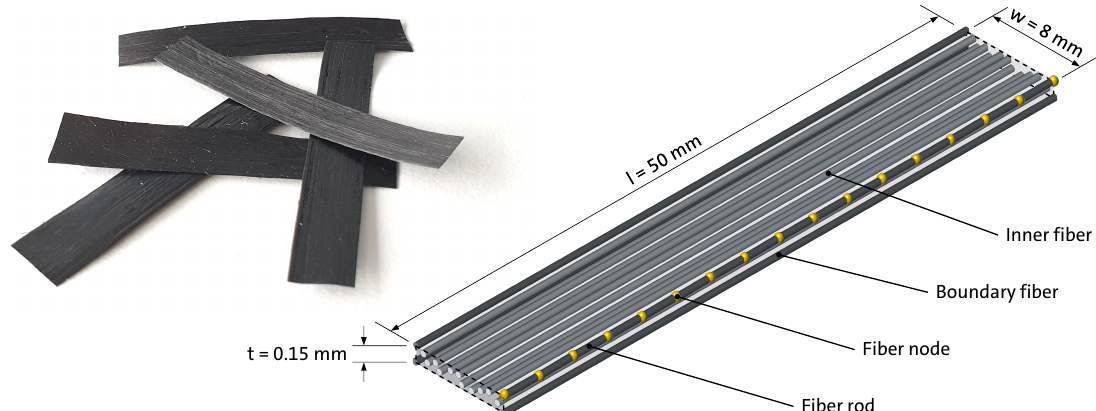
Figure 9. HexMC carbon fiber UD strands and a schematic illustration of their numerical counterpart modeled in 3D TIMON CompositePRESS with 4 boundary fibers defining the outer strand dimensions and 11 added inner fibers (here each fiber consists of 20 nodes and 19 rods, indicated on just one boundary fiber) (note: for visualization purposes length specifications are not true to scale).